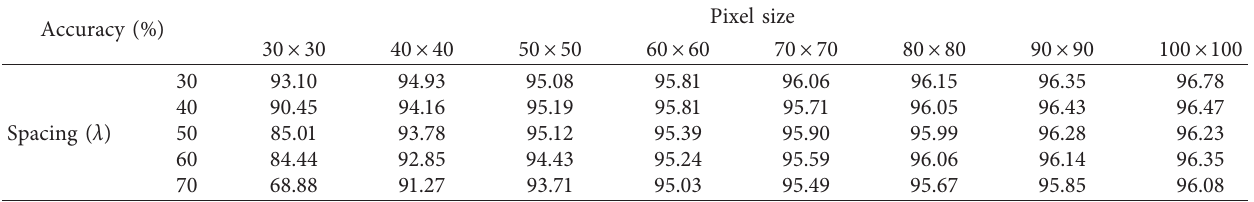
Table 9: The classification accuracy in the N-D 2 NN model adding the RReLU activation function corresponds to pixel size and diffraction grating